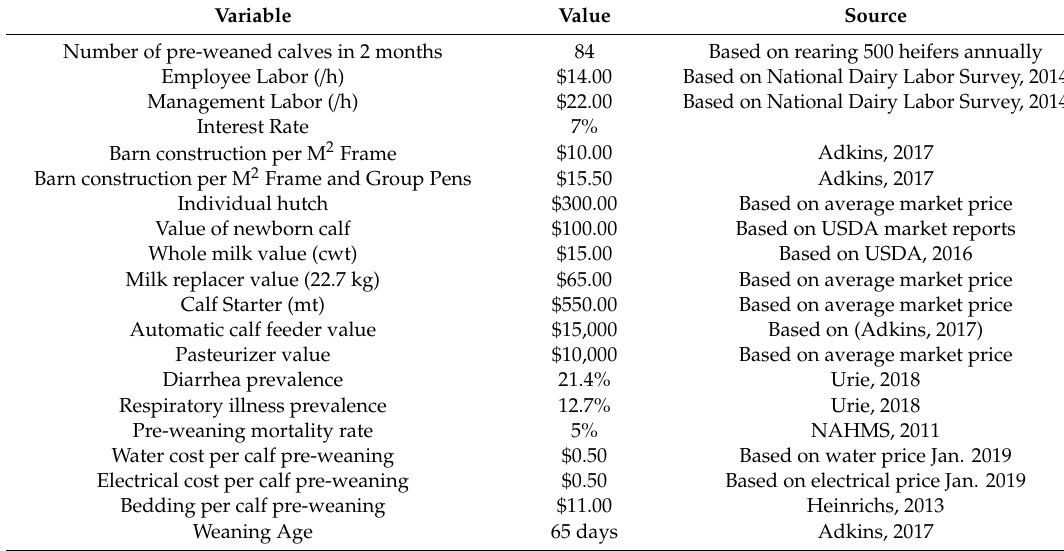
Table 1. Model inputs were adapted from the published literature, the latest USDA reports, and heifer raising